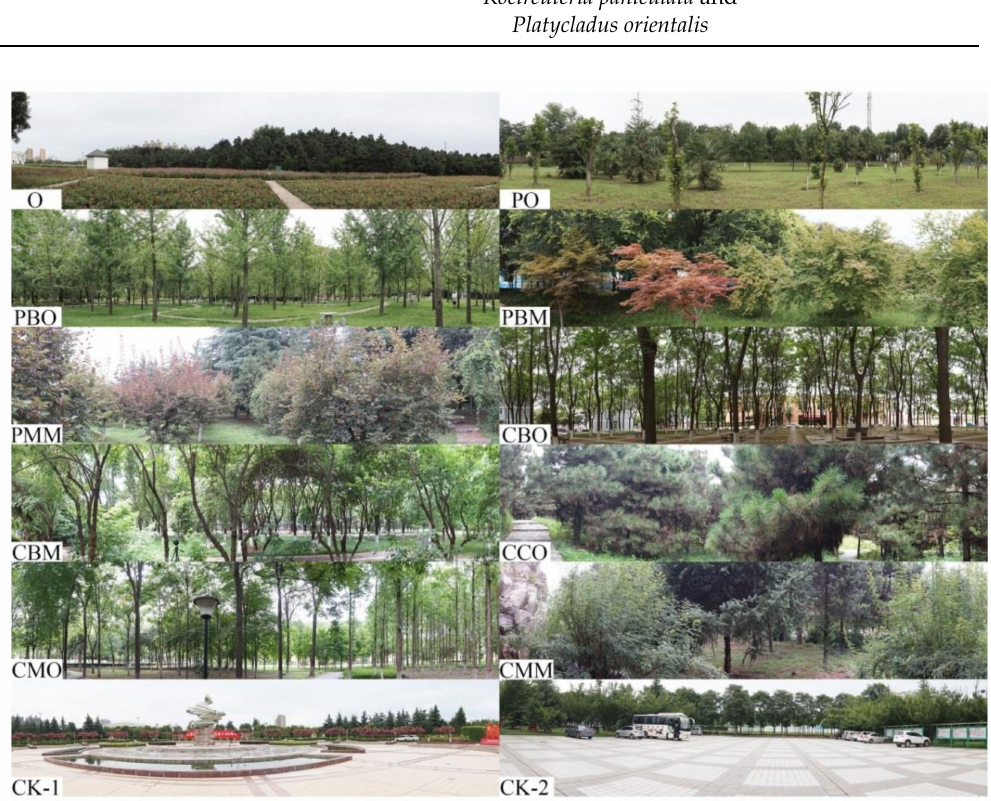
Figure 3. Panoramic views of 10 different vegetation structures (O: open lawn; PO: partially open green space; PBO: partially closed broad-leaved one-layered forest; PBM: partially closed broad-leaved multi-layered forest; PMM: partially closed coniferous and broad-leaved mixed multi-layered forest; CBO: closed broad-leaved one-layered forest; CBM: closed broad-leaved multi-layered forest; CCO: closed coniferous one-layered forest; CMO: closed coniferous and broad-leaved mixed one-layered forest; CMM: closed coniferous and broad-leaved mixed multi-layered forest; CK: the control